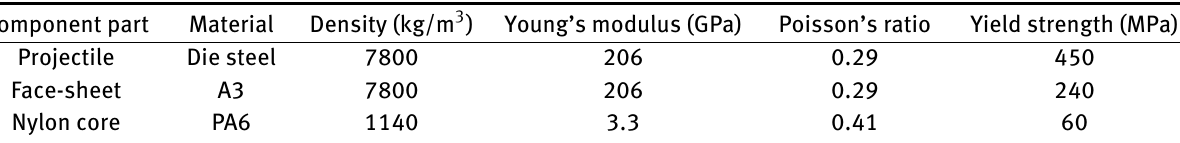
Table 1: Mechanical properties of the projectile, the face-sheet and the nylon